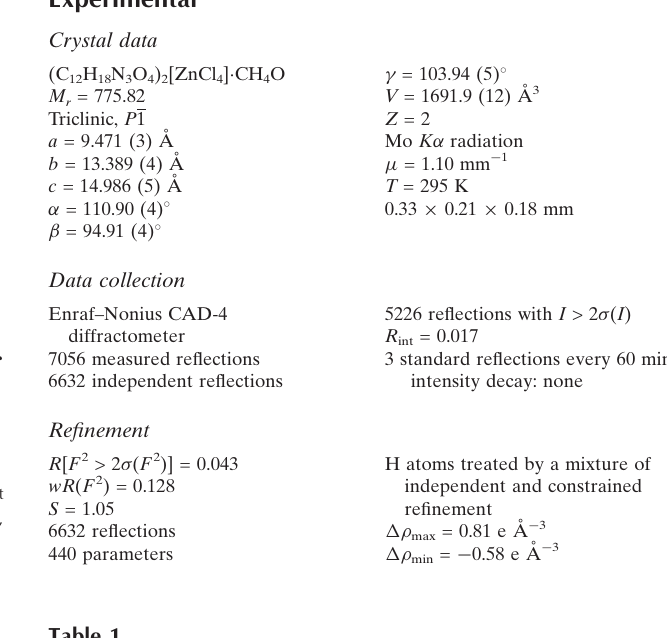
Hydrogen-bond geometry (A˚ , (cid:3)